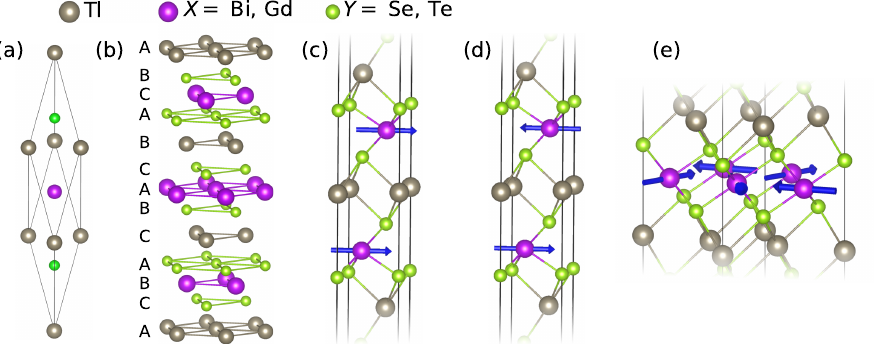
Figure 1. ( a ) Rhombohedral unit cell of Tl XZ 2 ( X = Bi, Gd, and Z = Se, Te), with grey, purple, and green balls showing Tl, X , and Z atoms, respectively. ( b ) Sketch showing the hexagonal character of the atomic layers as well as the ABCABC stacking. ( c , d ) Interlayer FM ( c ) and AFM ( d ) alignment of the FM Gd layers. The blue arrows show the orientations of the magnetic moments. ( e ) Intralayer non-collinear 120 ◦ AFM